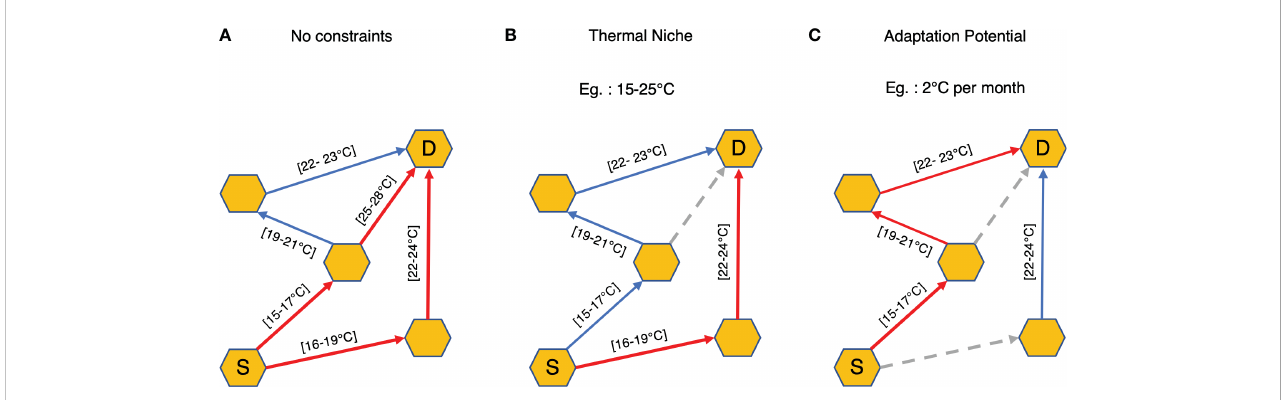
FIGURE 3 Schematic representations of different constraints applied on the connectivity graph G. Red arrows indicate the minimum connectivity time paths between Source cell (S) and Destination cell ( D ) for each case. Blue arrows represent the other valid transitions for the given scenario and dashed grey arrows are the dropped connections under the given constraints. Minimum and maximum temperatures for a given transition are provided in the square brackets beside the arrows. In case of (A) no thermal constraints, all the transitions are considered. For scenarios (B) Thermal Niche and (C) Adaptation Potential, transitions that do not conform to the constraints are